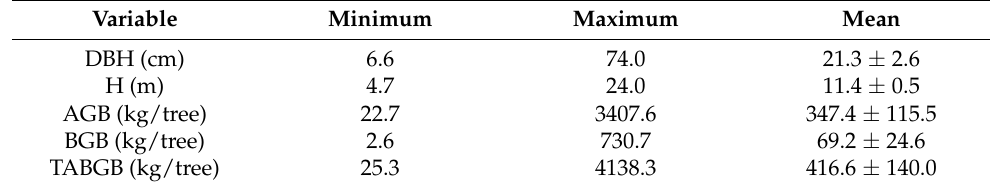
Table 4. Allometric equations for aboveground biomass, belowground biomass, and total above- and belowground biomass (using 30 tree